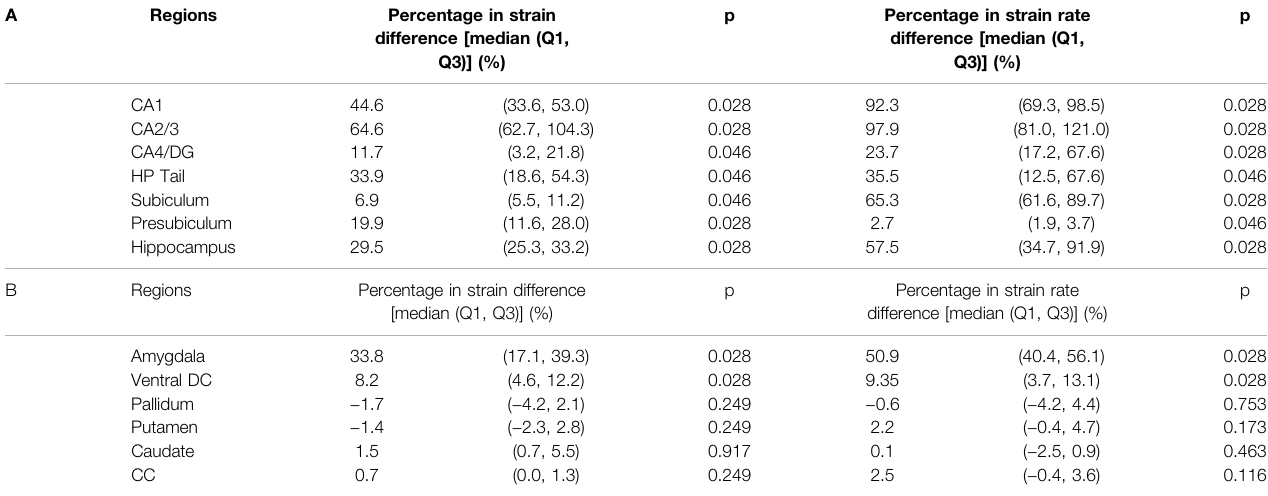
TABLE 3 | Wilcoxon matched-pairs signed-rank test on the region-wise strain and strain rate in the hippocampal sub fi elds and whole hippocampus (A) and non- hippocampalregions (B) (N=6).PercentagesinstraindifferenceandstrainratedifferencebetweentheTH-ModelandNTH-modelwerecalculatedacrossallsimulations and presented in the form of median and two quartile values with Q1 as 25th percentile value and Q3 as 75th percentile value. Note that N equals to the number of impacts simulated by each model. CA: cornu ammonis; DG: dentate gyrus; HP Tail: hippocampal tail; Ventral DC: ventral diencephalon; CC: corpus callosum. A